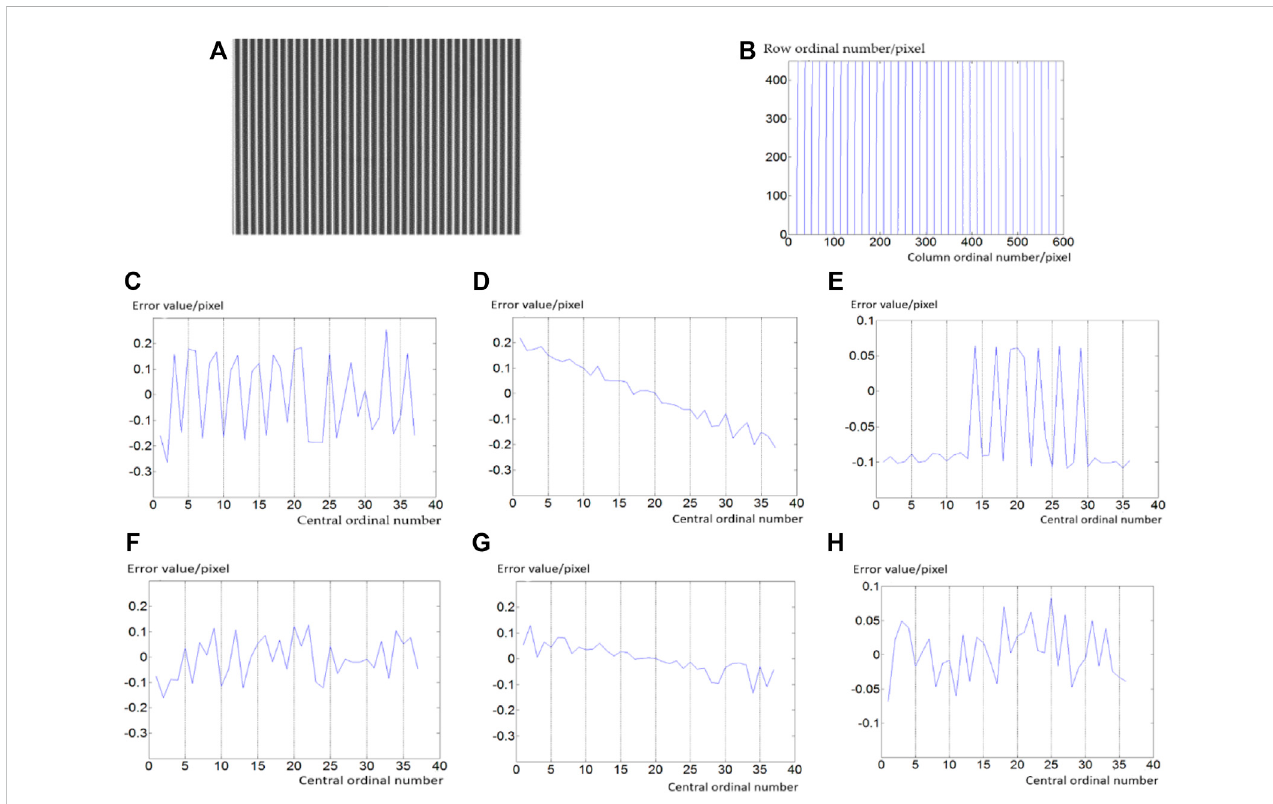
FIGURE 8 Line-shift stripe center detection. (A) Stripe image; (B) The fi tting center line; (C) Gray Gravity method straightness; (D) Straightness with this article method; (E) Gray Gravity method parallelism; (F) Parallelism with this article method; (G) Gray Gravity method equidistance; and (H) Equidistance with this article method.